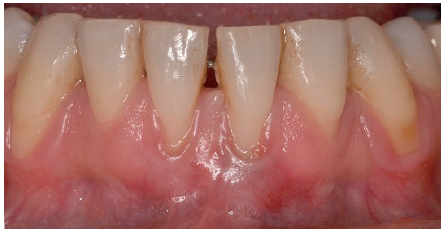
Figure 2. Pre-operative aspect of lower incisors presenting thin gingival biotype, gingival recession, minimal attached and keratinized gingiva width and muscle and frenum pull.